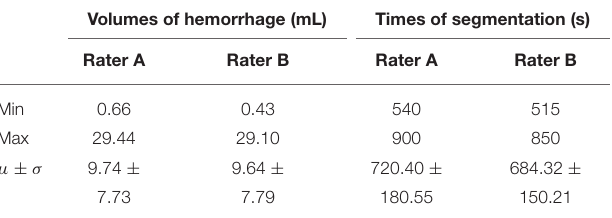
TABLE 1 | Summary of segmentations manually by two independent raters. Volumes of hemorrhage